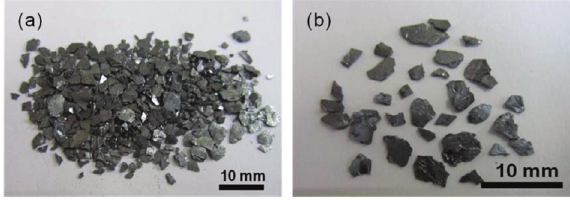
Figure 5: Images of plate-like primary Si particles of Al – 30%Si – 20%Ga